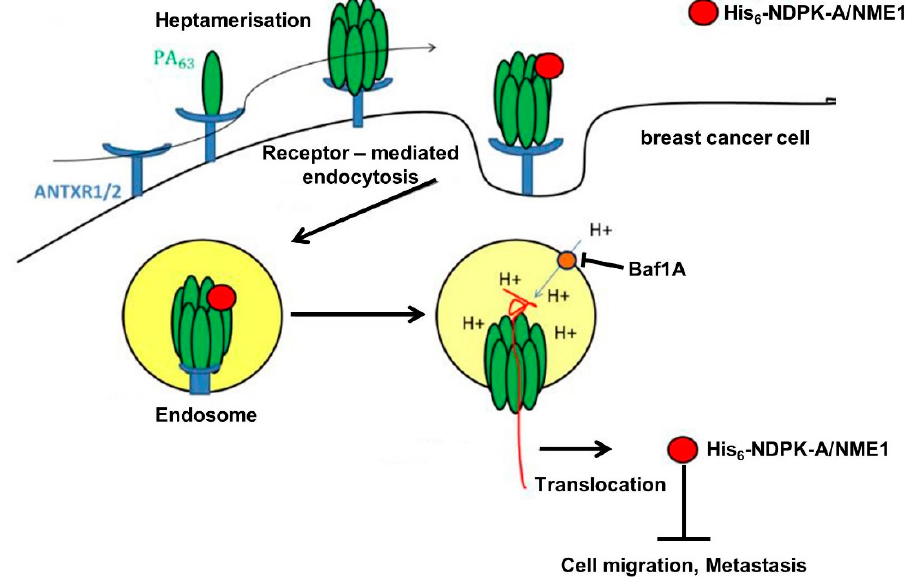
Figure 8. Schematic representation of the PA63-mediated transport of recombinant His-tagged NDPK-A / NME1 into the cytosol of human cancer cells. Explanations are given in the text. ANTXR1 / 2, anthrax toxin receptors 1 and 2; Baf A1, bafilomycin A1.